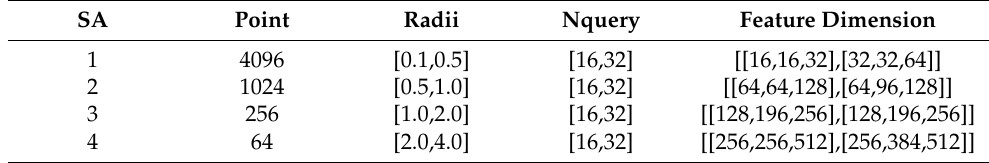
Table 1. SA layer parameter settings.